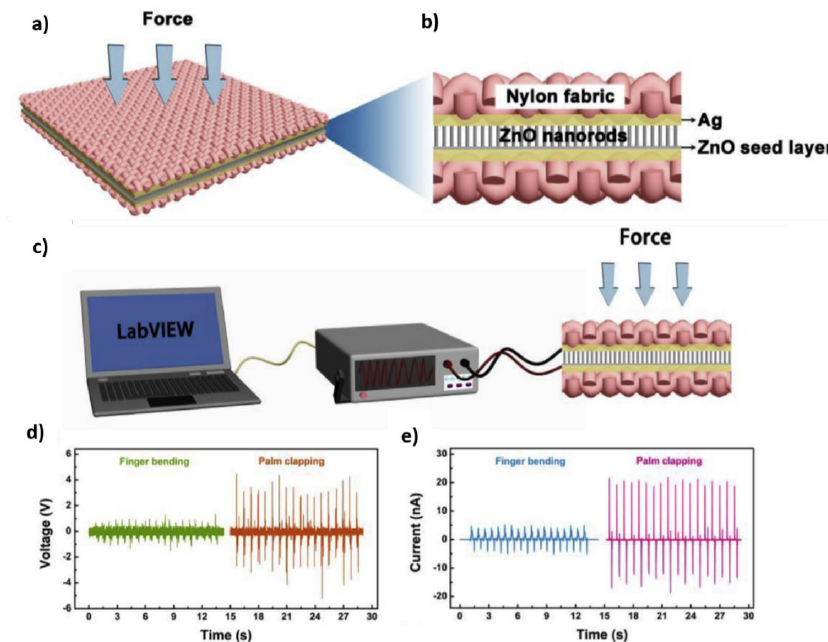
Figure 13. The structure of ZnO nanorods patterned textile based piezoelectric nanogenerator (PENG) ( a ); schematic diagram of PENG construction ( b ); schematic diagram of test system ( c ); output voltages ( d ) and currents ( e ) by finger bending and palm clapping. Reprinted with permission from